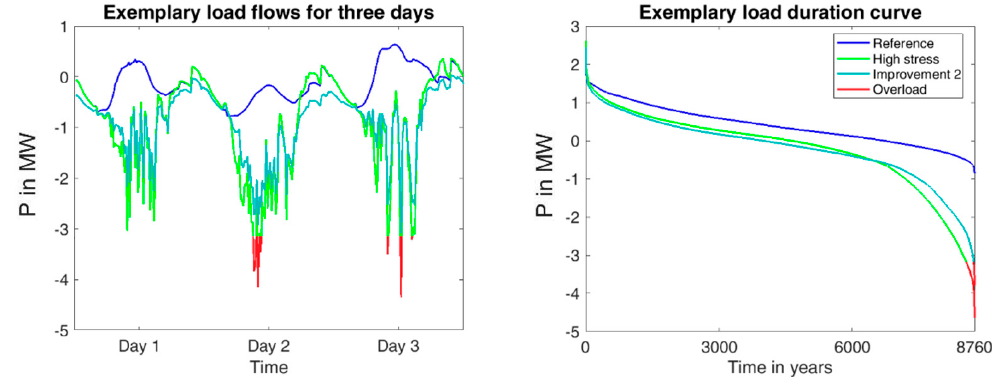
Figure 12. Exemplary electrical load flows of the power line Slack-1 in different scenarios.